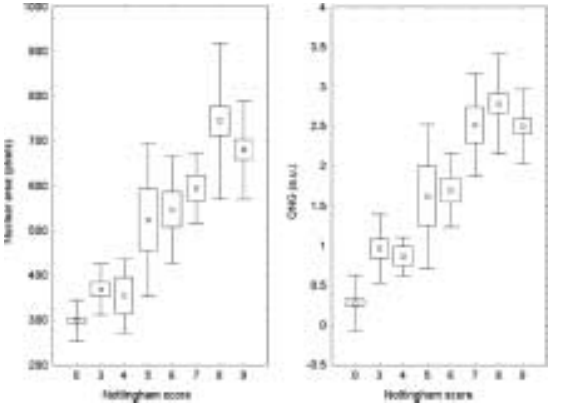
Fig. 6. Distribution of mean nuclear area and quantitative nuclear grade, with respect to categories of the Nottingham scoring system. of variation as input parameters. ANOVA was used